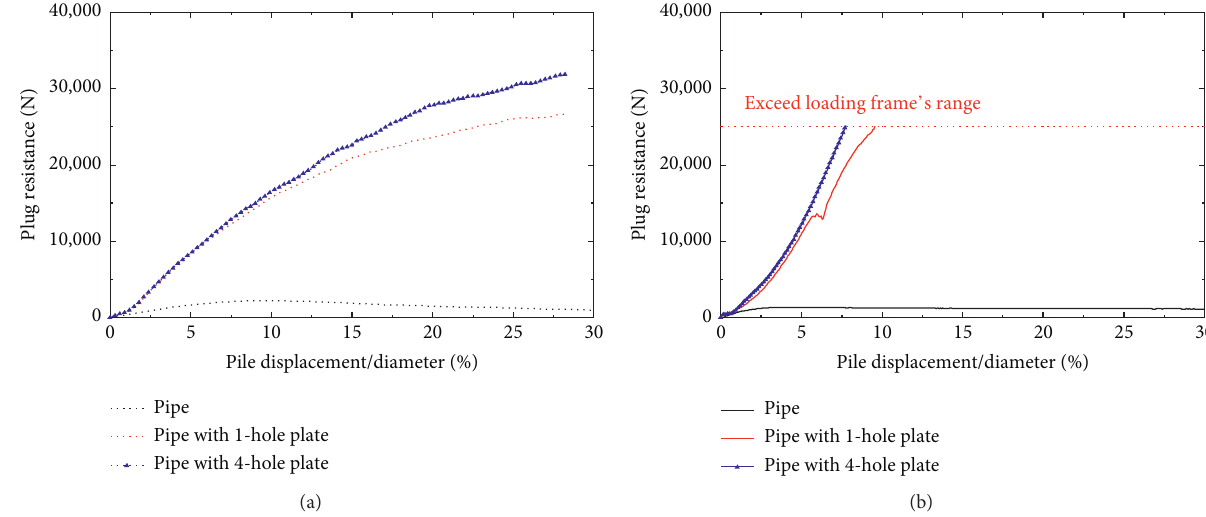
Figure 9: Axial force-displacement curves of pipe piles with different restriction plates: (a) simulation results and (b) experimental results.